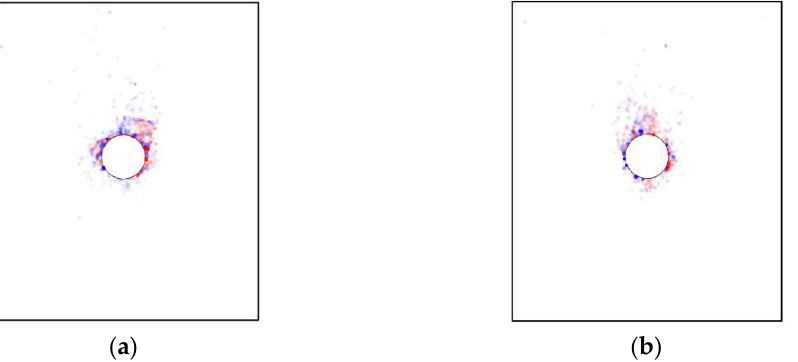
Figure 28. Particle rotation after the tunnel excavation in the cases of ( a ) AR2C1 and ( b ) AR2C2. Refer to Figure 12 for the